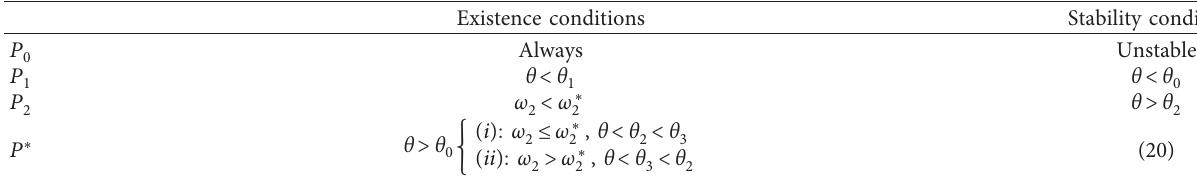
Table 1: The existence and stability conditions of each